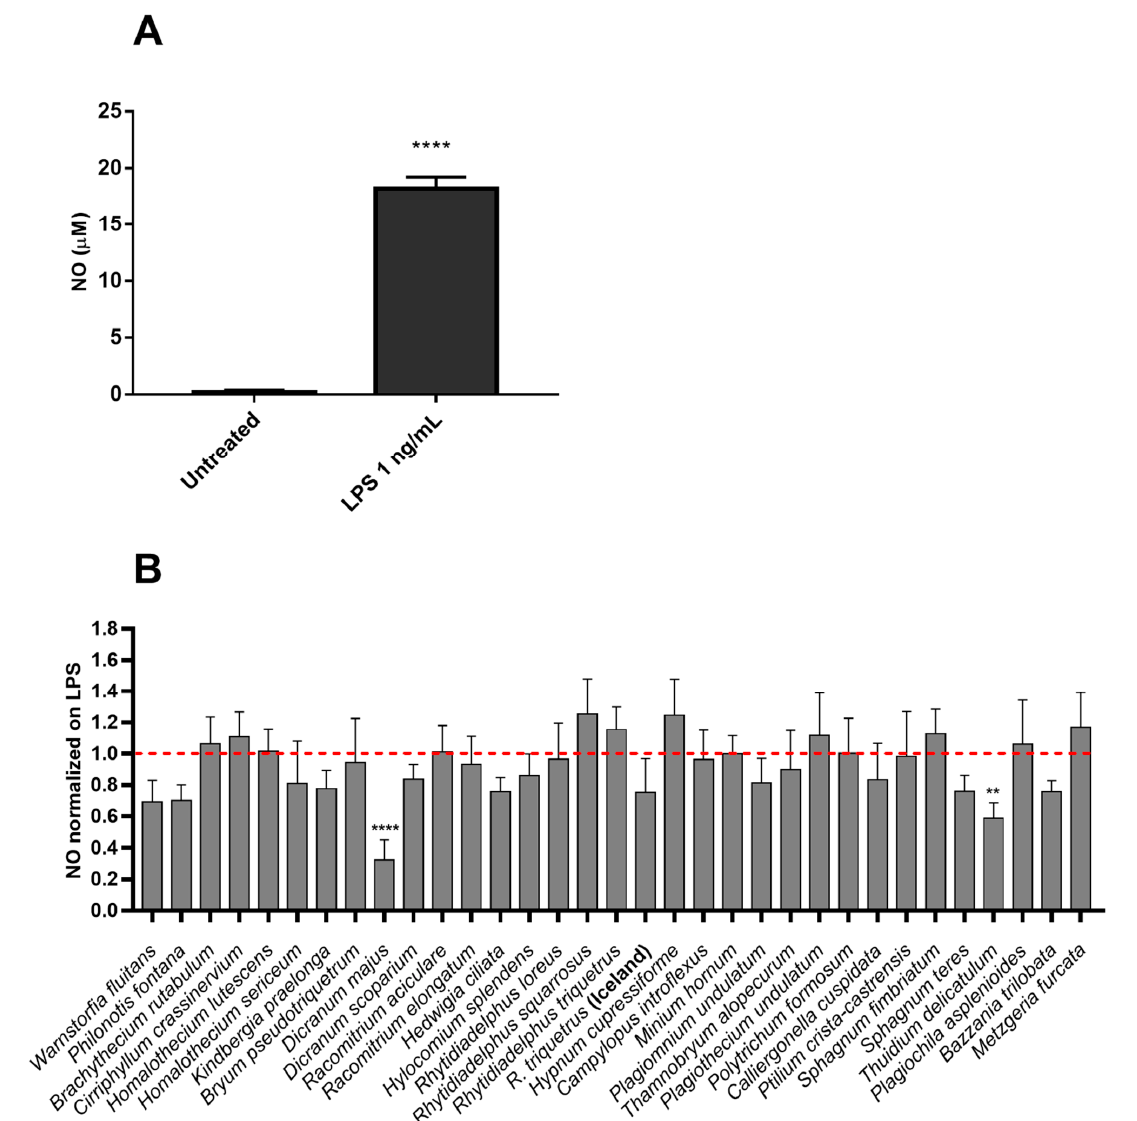
Figure 3. ( A ) LPS-NO induction in murine macrophages. The amount of NO in cells treated with LPS 1 ng/mL for 18 h is significantly different (**** p < 0.0001) compared to untreated cells. The graph represents the mean ± standard deviation of three independent experiments. ANOVA and Tukey’s test were used for statistical analysis. ( B ) Effect of 70% ethanol extracts on LPS-induced NO in RAW 264.7 cells. Cells pre-treated with 100 µ g/mL of extracts for 1 h were stimulated with LPS (1 ng/mL) for 18h, which is enough to induce a significant signal. The NO content of the culture medium was analyzed by the Griess reagent method. Data represent mean ± standard deviation (n = 7–11) and the results normalized by the effect of LPS (1 ng/mL) on untreated and stimulated cells. The tested extracts revealed a significant difference with p -values < 0.05, calculated with ANOVA. ** p < 0.01, **** p < 0.0001 indicate significant differences compared to the control. The dashed line represents the level of NO in cells stimulated by LPS alone. The amount of nitrite in the media was calculated from sodium nitrite standard